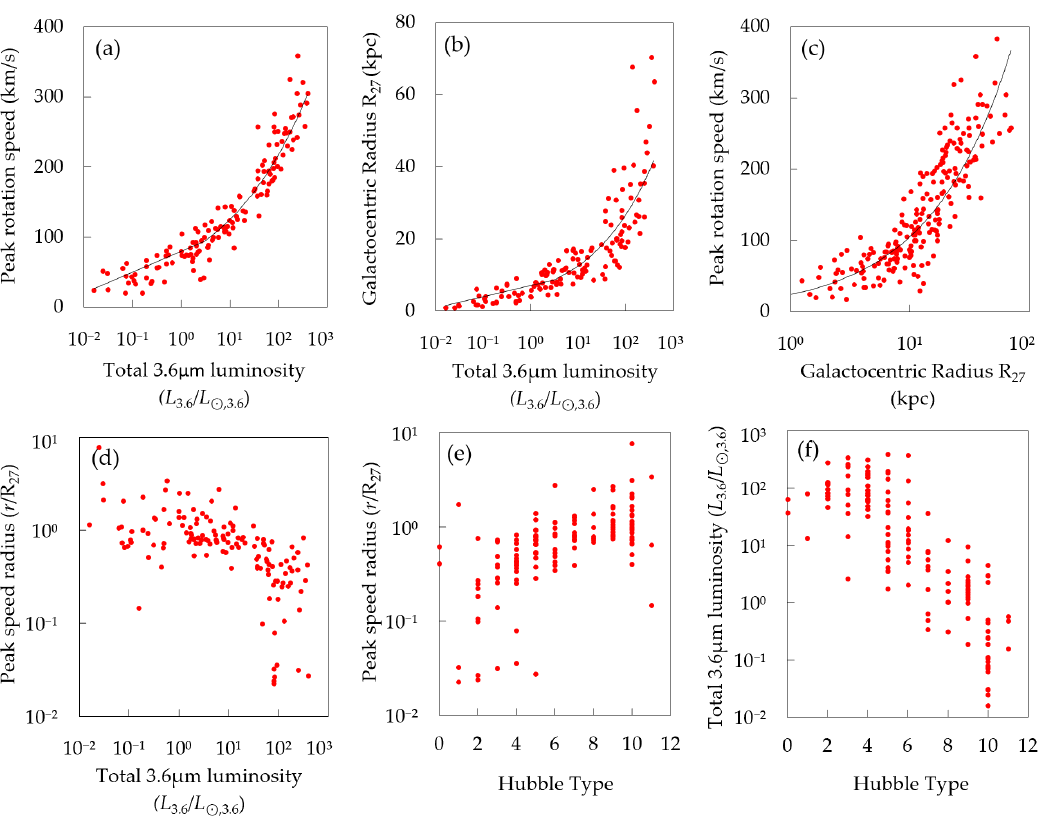
Figure 4. Summary statistics for 214 galaxies: ( a ) Peak rotation velocity vs. total 3.6 µ m luminosity; ( b ) R 27 vs. total 3.6 µ m luminosity; ( c ) peak rotation velocity vs. R 27 ; ( d ) radial position of peak rotation velocity vs. total 3.6 µ m luminosity; ( e ) radial position of peak rotation velocity vs. Hubble type; ( f ) total 3.6 µ m luminosity vs. Hubble type. Luminosity values are shown in 3.6 µ m solar luminosity units. R 27 is the radius at which 3.6 µ m apparent surface brightness fades to 27 mag AB / arcsec 2 . Red - filled circles represent individual